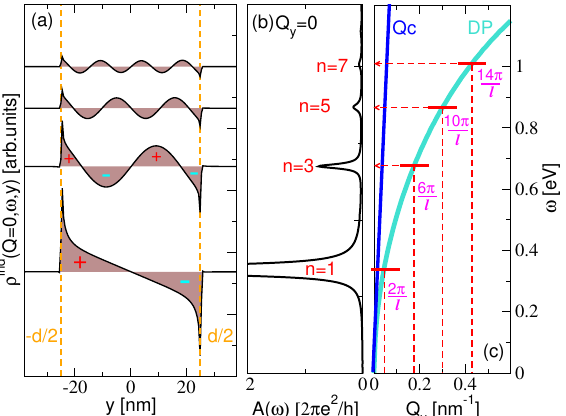
Figure 5. ( a ) The induced electronic densities ( ρ ind ∼ (cid:60) ∂σ yy / ∂ y ) calculated for Q y = 0, at the frequencies corresponding with the IR active resonances n = 1,3,5,7, in the KC 8 -NR of widths d = 50 nm deposited on a dielectric model Al 2 O 3 surface. The nanoribbon period is l = 2 d and z 0 = 3.0 Å; ( b ) The absorption spectrum corresponding to the modes in ( a ); ( c ) Schematic presentation of the ‘projection’ of the fractions of the DP (at Q y ≈ 2 π ( 2 k + 1 ) / l ; k = 0,1,2, . . .) into the radiative region where they become IR active